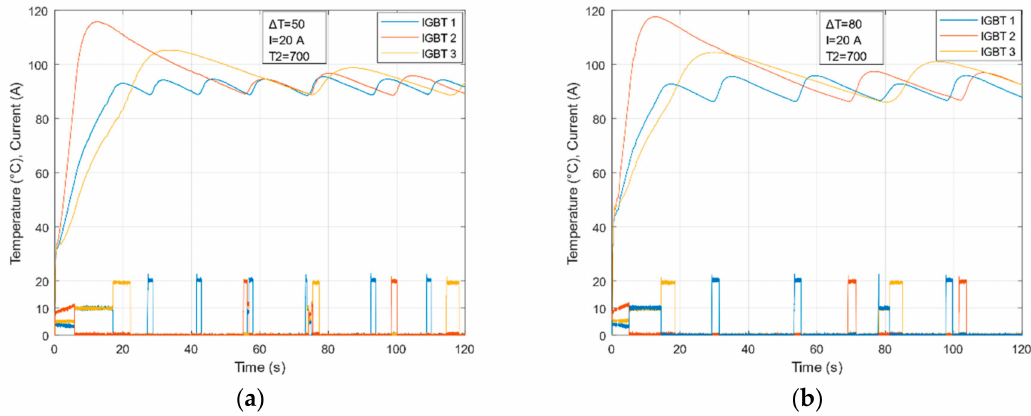
Figure 12. Temperature hysteresis ∆ T influence on three paralleled IGBTs for ( a ) ∆ T = 50; ( b ) ∆ T =